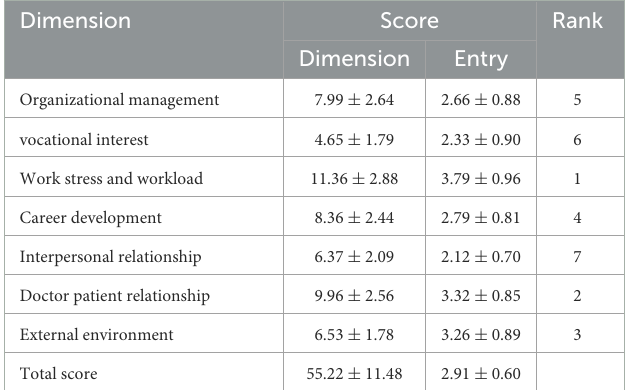
TABLE 1 Demographic characteristics of study participants ( n = 138). TABLE 2 Work stress scores of medical workers in combating the COVID-19 epidemic ( χ ± s, n = 138).